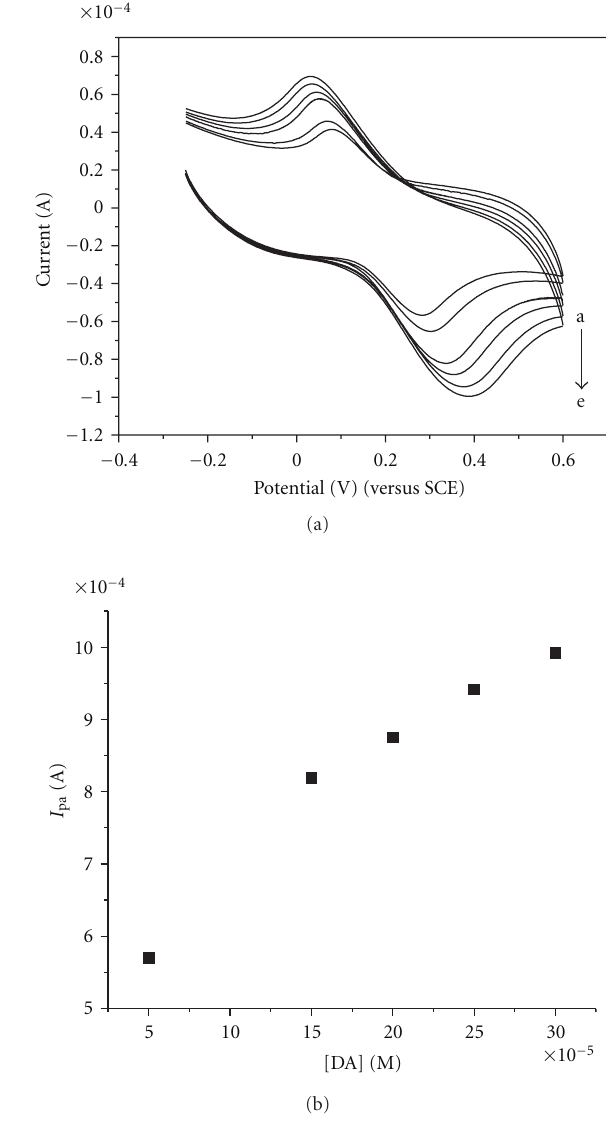
Figure 4: (a) Cyclic voltammogram for di ff erent concentrations of DA: (a) 5 × 10 − 5 M, (b) 15 × 10 − 5 M, (c) 20 × 10 − 5 M, (d) 25 × 10 − 5 M, and (e) 30 × 10 − 5 M at poly (gabapentin) film-coated carbon paste electrode with scan rate 0.1 Vs − 1 . (b) Graph of current versus concentration of